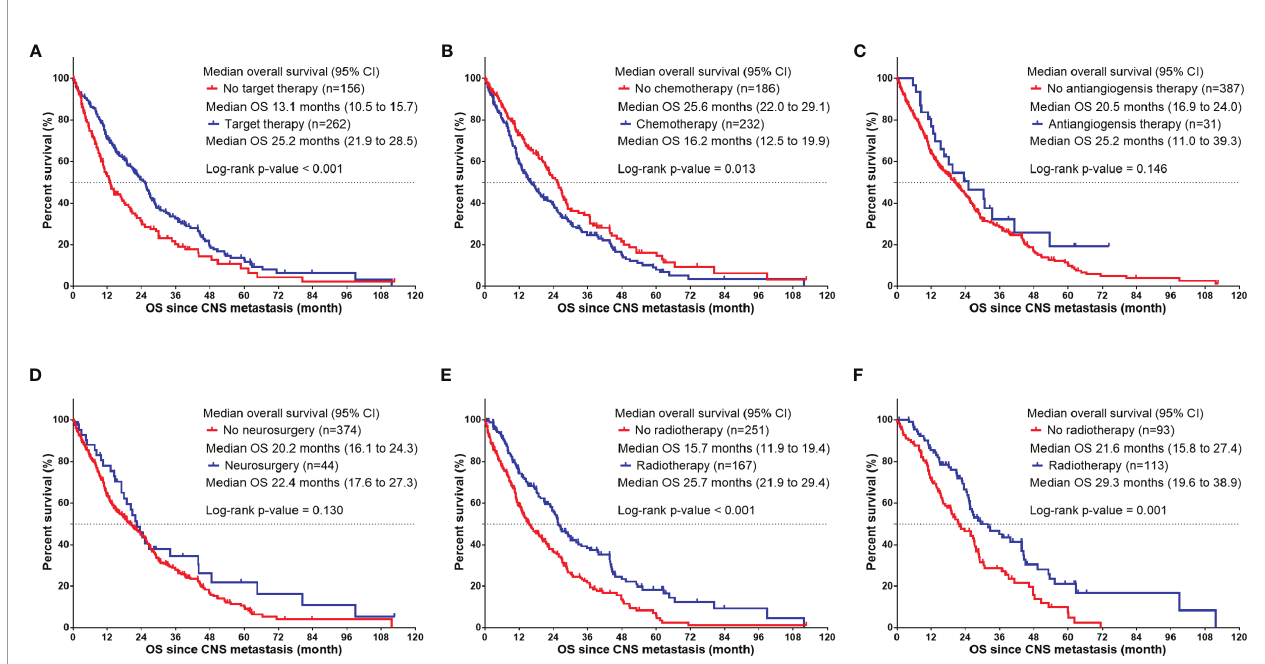
FIGURE 2 | Kaplan-Meier curve illustrating OS since CNS metastasis in NSCLC patients with various treatments: (A) with or without target therapy, (B) with or without chemotherapy, (C) with or without antiangiogensis therapy, (D) with or without neurosurgery, (E) with or without radiotherapy in all NSCLC patients with CNS metastasis, and (F) with or without radiotherapy in positive driver genes NSCLC patients with CNS metastasis. OS, overall survival; CNS, central nervous system; NSCLC, non-small cell lung